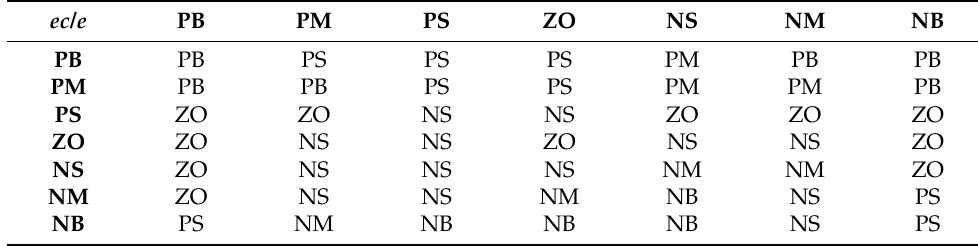
Table 4. Fuzzy rule control table of ∆ k D .